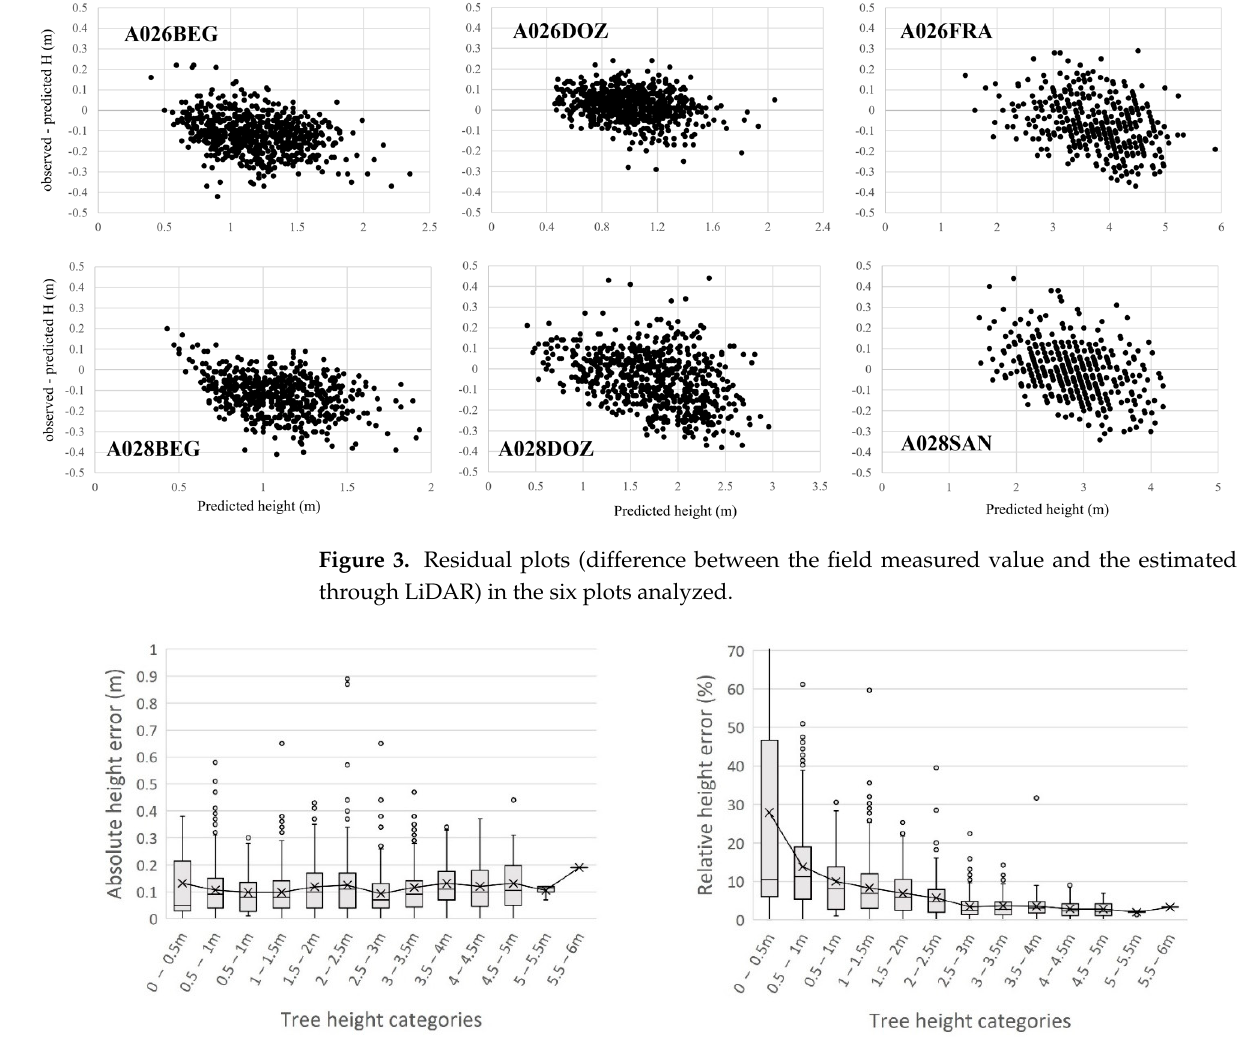
Figure 4. Absolute error ( left ) and percent relative error ( right ) for the tree height estimated directly on the LiDAR point cloud, and considering all sites, against tree height categories.